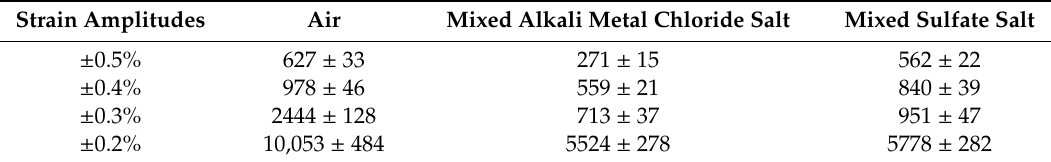
Figure 4. Cyclic stress response of alloyed steel in different environments ( a ) ±0.2%, ( b ) ±0.3%, ( c ) ±0.4%, and ( d ) ±0.5%. Table 5. Fatigue life of specimens in the three environments (cycles).